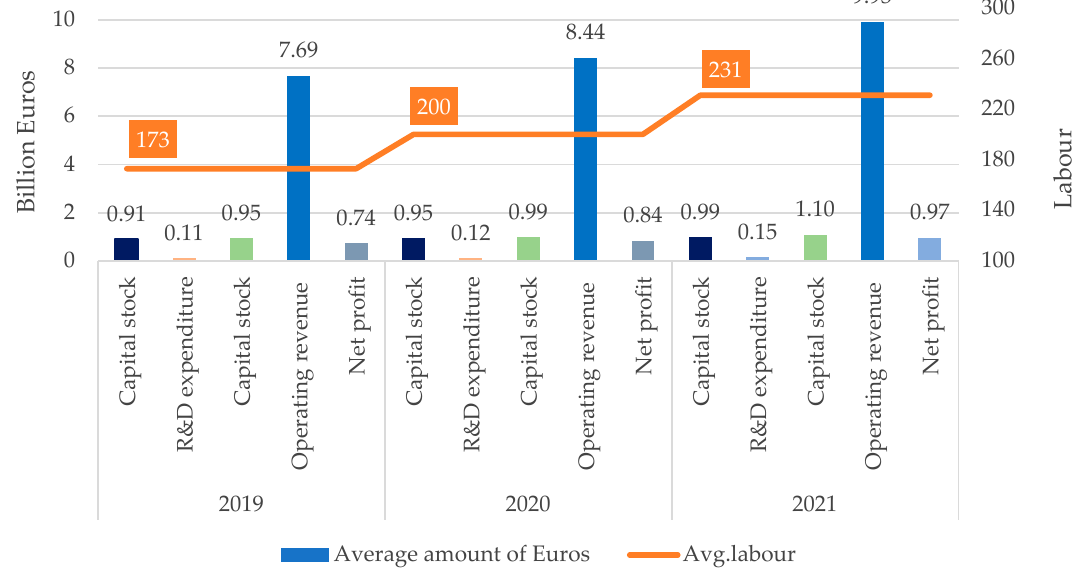
Figure 3. Average value of selected indicators per year.